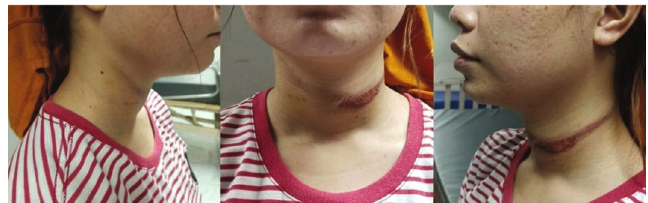
Figure 1: Neck contusion after suicide attempt by